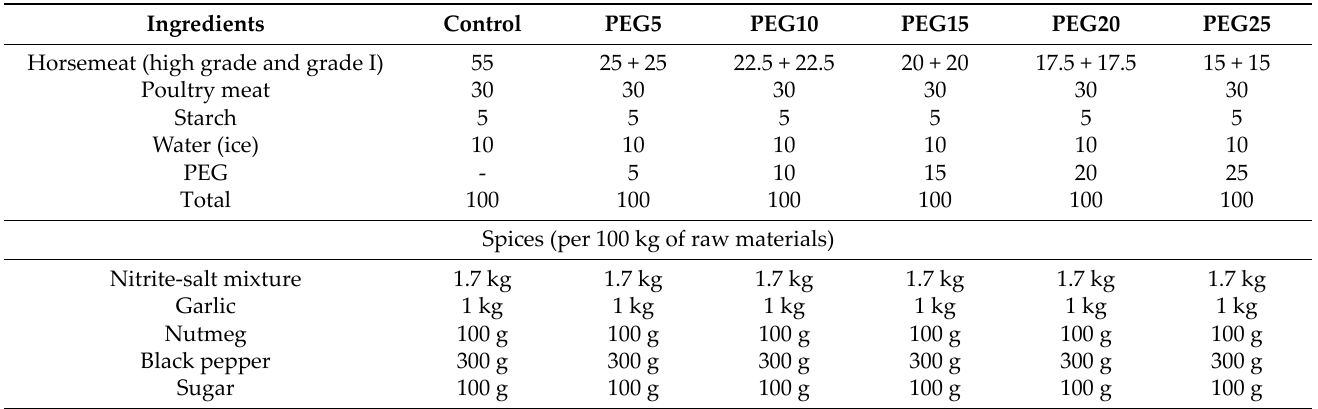
Table 1. The formulation for control and “Narli” semi‑smoked